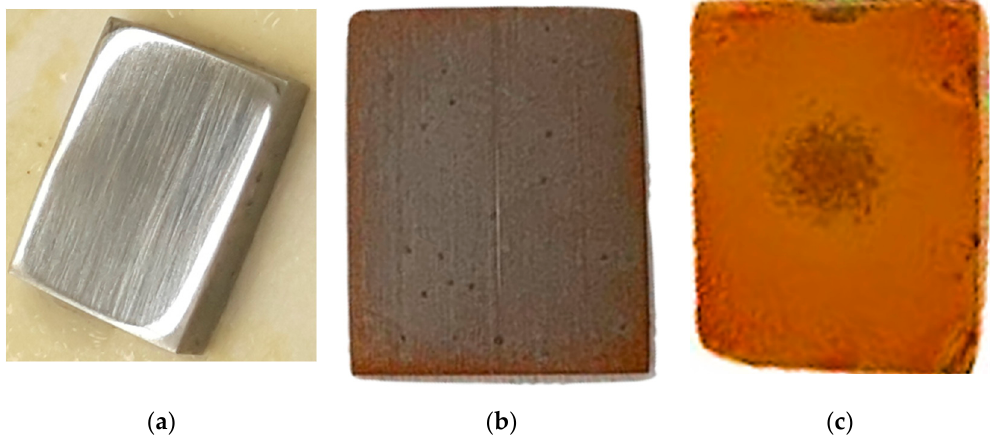
Figure 11. Visual images of blank and corroded surfaces of specimens, ( a ) Blank carbon steel specimen, ( b ) Carbon steel In GTL water at 0 rpm and 323 K, ( c ) Carbon steel In GTL water at 1000 rpm and 298